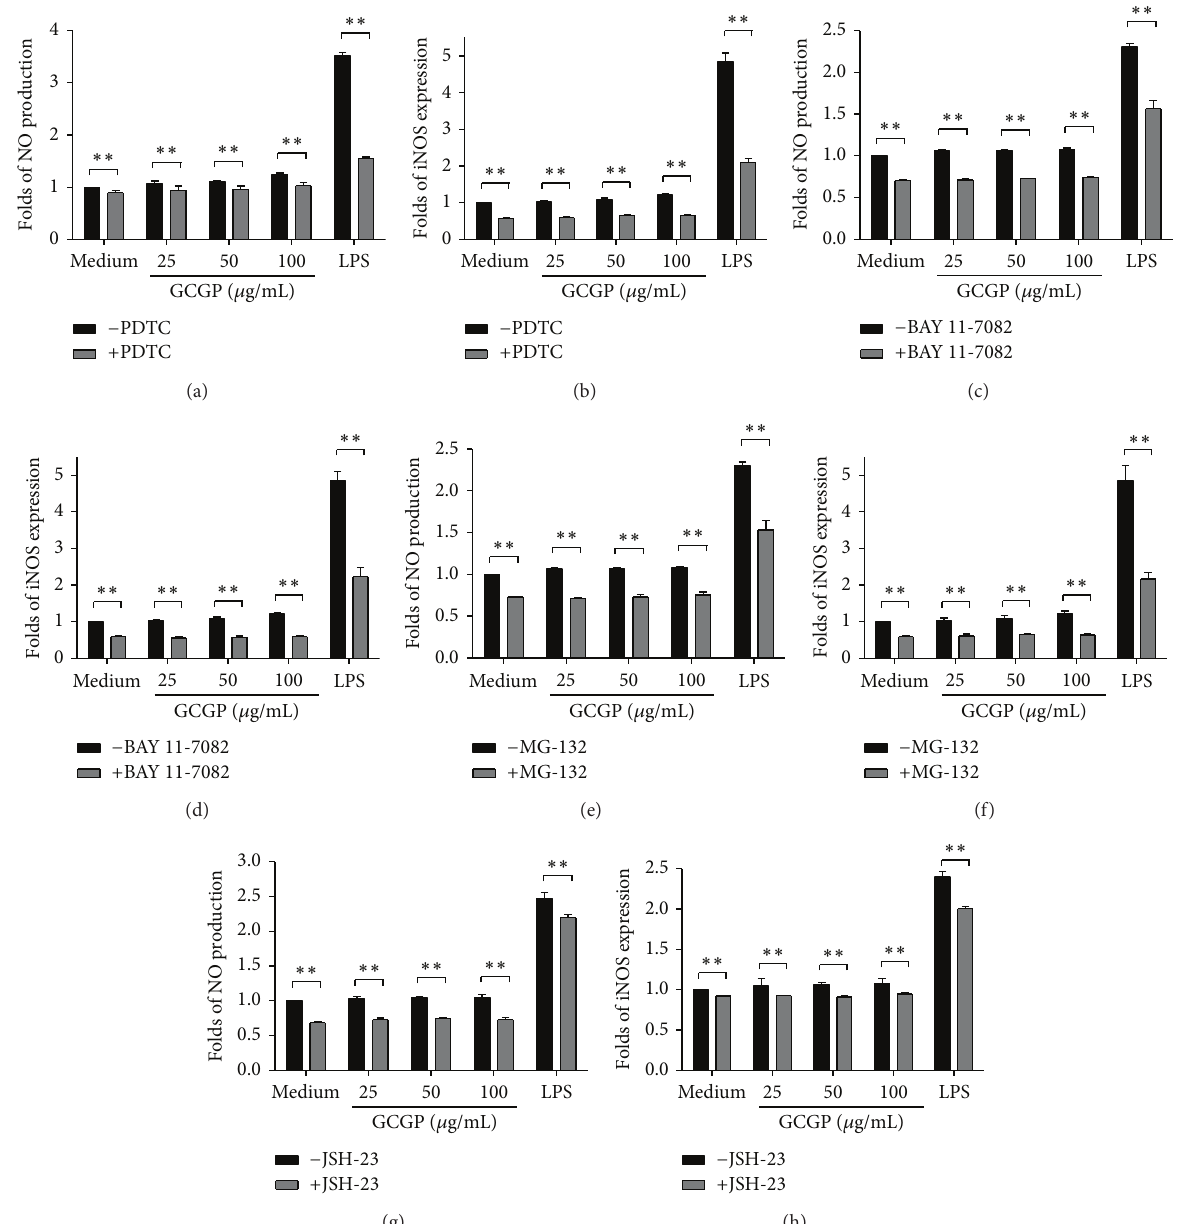
Figure 3: Effect of NF- 𝜅 B inhibitors on NO production and iNOS expression induced by GCGP. Cells were pretreated with 50 𝜇 M PDTC ((a) and (b)), 50 𝜇 M BAY 11-7082 ((c) and (d)), 25 𝜇 M MG-132 ((e) and (f)), or 40 𝜇 M JSH-23 ((g) and (h)) at 37 ∘ C for 30min; then the indicated concentrations of GCGP were added for culturing 24h. NO production and iNOS expression were analyzed as described in Materials and Methods. Results correspond to the mean ± SD of three independent experiments. ∗∗ 𝑃 < 0.01